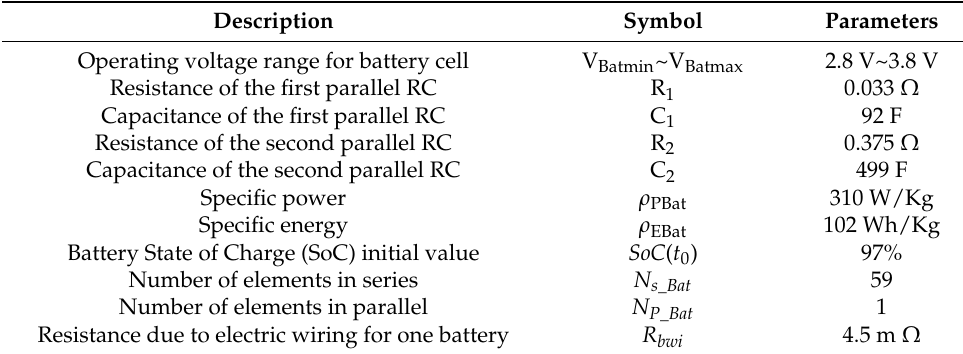
Table 2. Parameters of LiFePO 4 -batteries